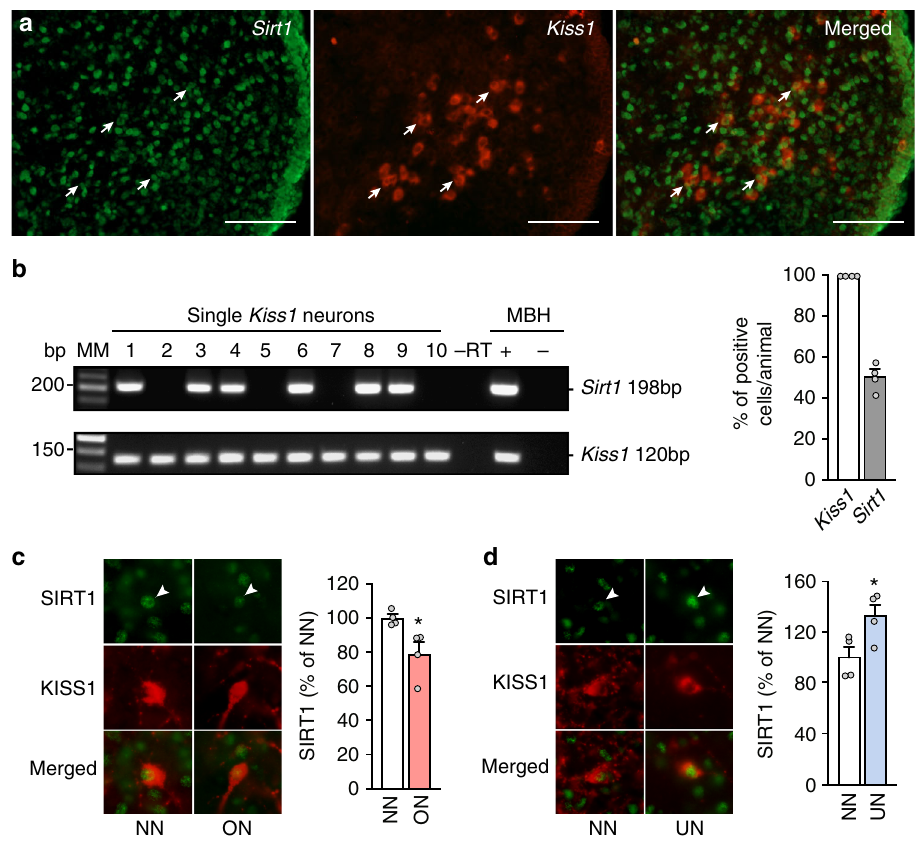
Fig. 6 Sirt1 is expressed in KNDy neurons and SIRT1 content changes with nutritional status. a Fluorescent in situ hybridization (FISH) using a cRNA complementary to Kiss1 mRNA (red) and a cRNA probe recognizing Sirt1 mRNA (green) in KNDy neurons of the ARC. Arrows point to examples of double labeled cells. Scale bars, 100 µ m. b A representative gel illustrating the presence of Sirt1 and Kiss1 mRNA in ten eGFP-tagged mouse KNDy neurons (1 − 10) of adult ovariectomized female mice as detected by single-cell (sc) PCR. As a negative control, the PCR reaction was performed on a Kiss1-GFP cell in the absence of reverse transcription ( − RT). Other negative controls (showing no PCR product) included harvested aCSF and water blank. RNA extracted from the MBH was included as a positive control ( + , with RT) and negative control ( − , without RT). MM molecular markers, bp base pairs. The bar graph represents the mean ± SEM of the percentage of KNDy neurons expressing Sirt1 per animal from four mice and a total of 96 harvested Kiss1- positive cells. c , d Immunohisto fl uorescence detection of SIRT1 (green) and kisspeptin (red) from the ARC of NN (normal-nutrition) vs. ON (overnutrition) rats at PND29 (panel c ), or NN vs. UN (undernutrition) animals at PND36 (panel d ). Bar graphs represent the mean ± SEM of the percentage of SIRT1 signal intensity in kisspeptin-positive cells from 30 to 50 neurons per animal, normalized against NN data. * p < 0.05 (two-sided Student ’ s t test) ( n = 4 animals per group). NN = white bars; ON = light red bars; UN = light blue